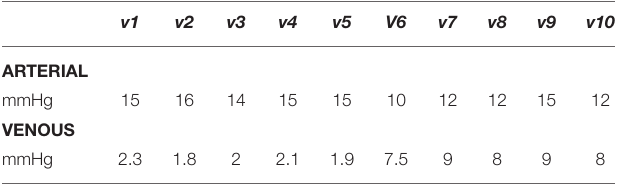
V stands for each animal and the according A. carotis and V. jugularis